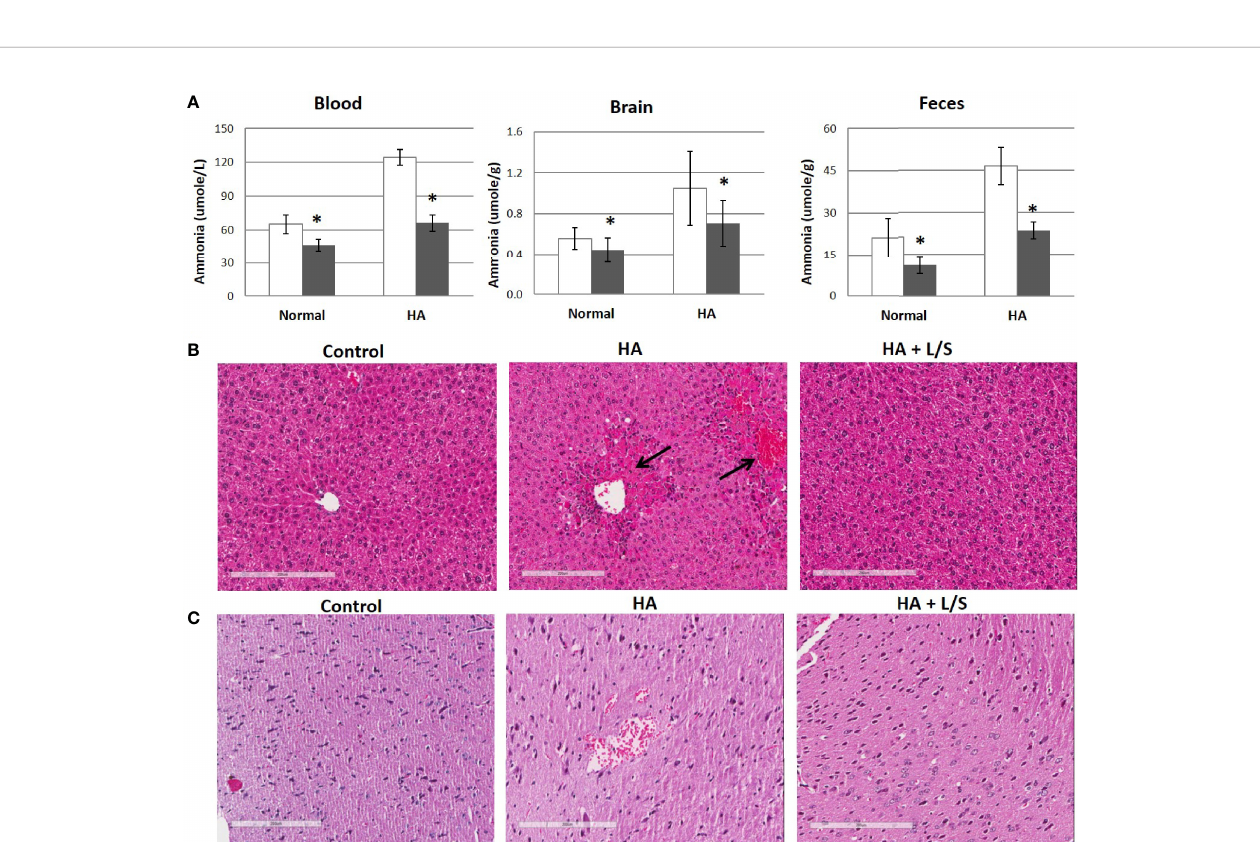
FIGURE 4 | The therapeutic ef fi cacy of the symbiotic pair of L. reuteri JBD400 and S. rubneri for Hyperammonemia. The symbiotic pair of L. reuteri JBD400 and S. rubneri JBD420, 10 9 CFU each in the total volume of 200 m L PBS, was daily administered into each C57BL/6 mice (n = 3 per group) for 40 days. (A) Acute hyperammonemia were induced by the injection of TAA at the dose of 250 mg/kg body weight of mice, and ammonia levels were quantitated in the tissue from mice which fed either saline control (open column) or fed symbiotic pair (black column). Normal mice without hyperammonemia induction were analyzed for saline control (open column) or fed symbiotic pair (black column). All data were expressed as the mean ± SD, as indicated. The statistical comparisons were analyzed using ANOVA (one-way). All differences were considered statistically signi fi cant if p < 0.05. (B, C) After inducing hyperammonemia, the sampled tissues were also analyzed by histological examinations on the H&E-stained section of livers (B) and brains (C) from control mice without hyperammonemia induction (Control), the hyperammonemic mice (HA), and the hyperammonemic mice fed the symbiotic pair (HA+L/S). Magni fi cations were × 200. Bar =200 µm. * indicates signi fi cant difference compared to the control.